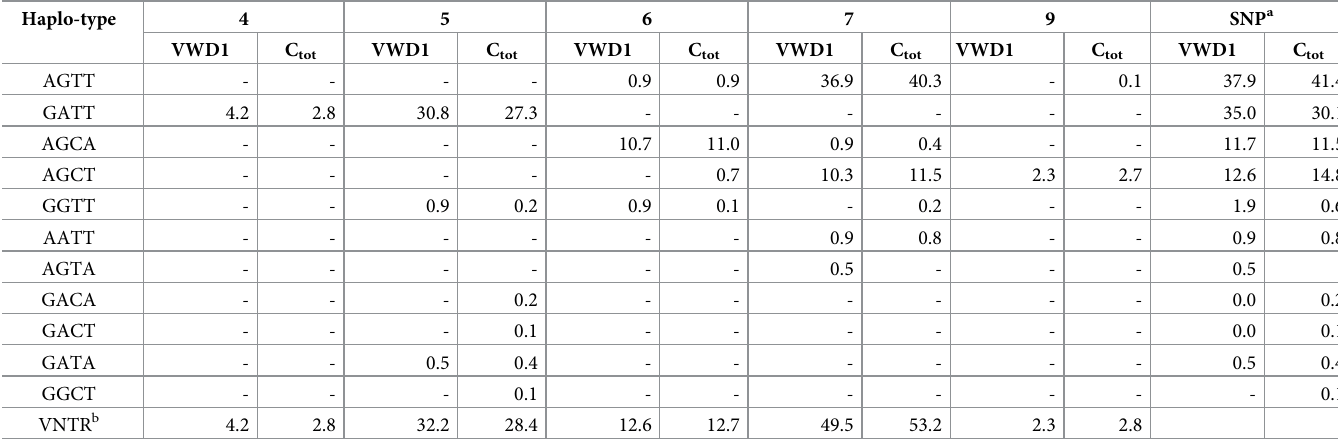
Table 5. Combined SNP-VNTR haplotype